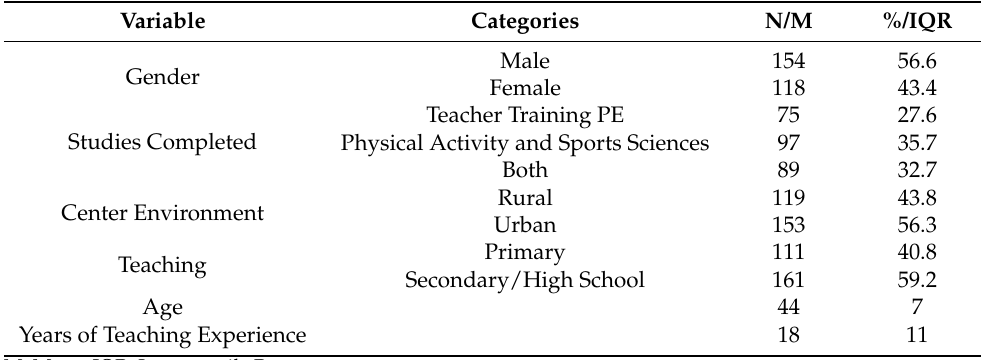
Table 1. Frequency distribution of the sample (N =